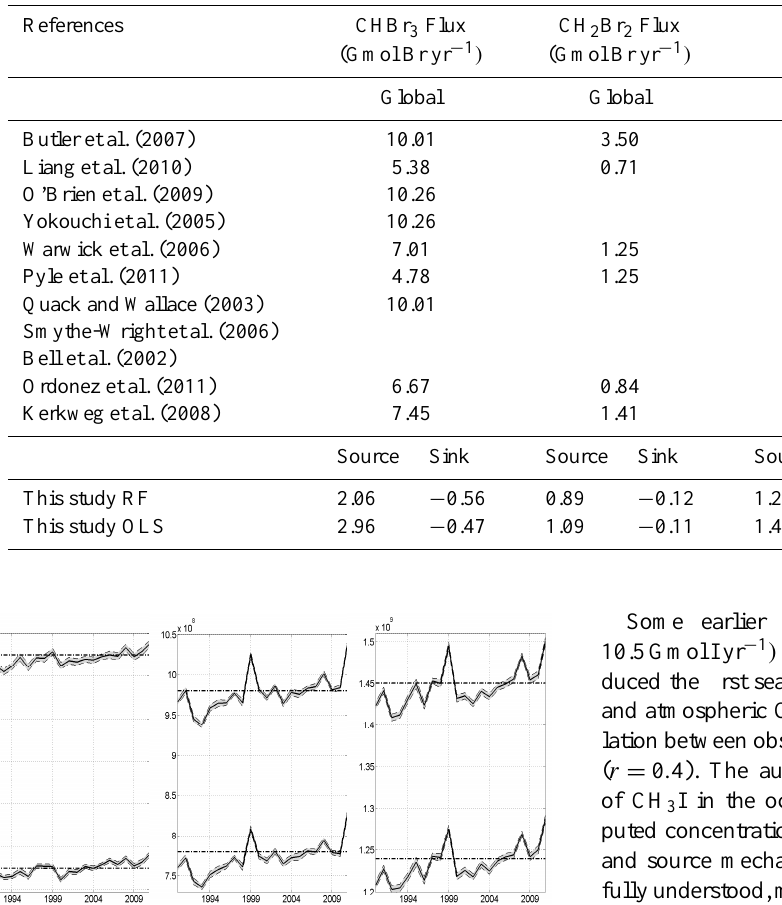
Fig. 7. Inter-annual sea-to-air flux variability over 1989–2011 (bold solid line) of bromoform (left), dibromomethane (centre) and methyl iodide (right) calculated with the two regression techniques (RF (lower panels) and OLS (upper panels)), in Gmol (Br/I) yr − 1 . Additionally, the respective climatological value is marked (dash- dotted line) as well as the standard deviation (grey